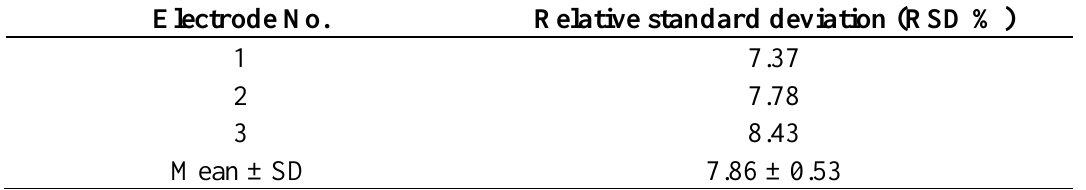
Table 1. Reproducibility of L -lactic acid measurements using the L -lactic acid biosensor (n = 25). The measurement was performed using 5 mg·dL − 1 L -lactic acid in PBS, pH 8.0, 30 °C under a +650 mV potential ( vs. Ag/AgCl).